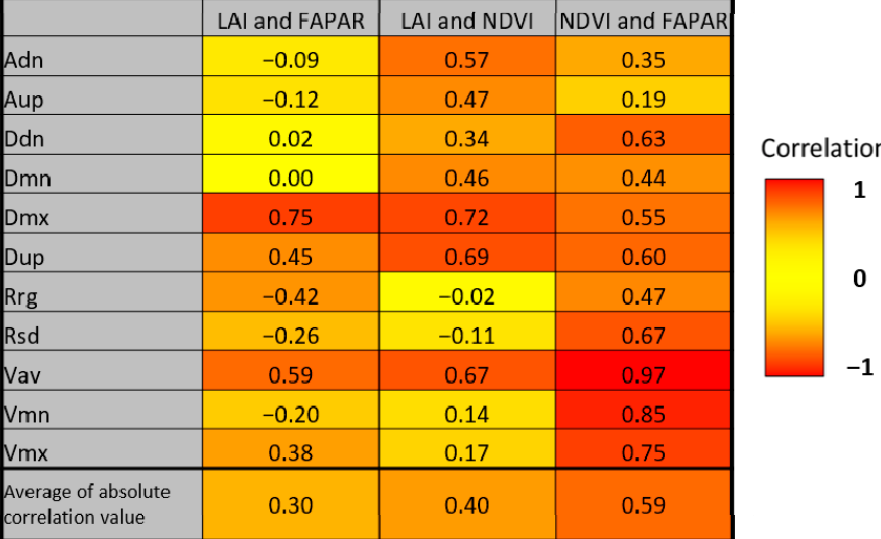
Figure 6. Pearson correlation coefficient of the 11 phenological variables computed over the period of dekad 1 (start of January) to dekad 18 (end of June) of the years 2000 to 2019 between the three biophysical satellite products LAI, NDVI, and FAPAR.